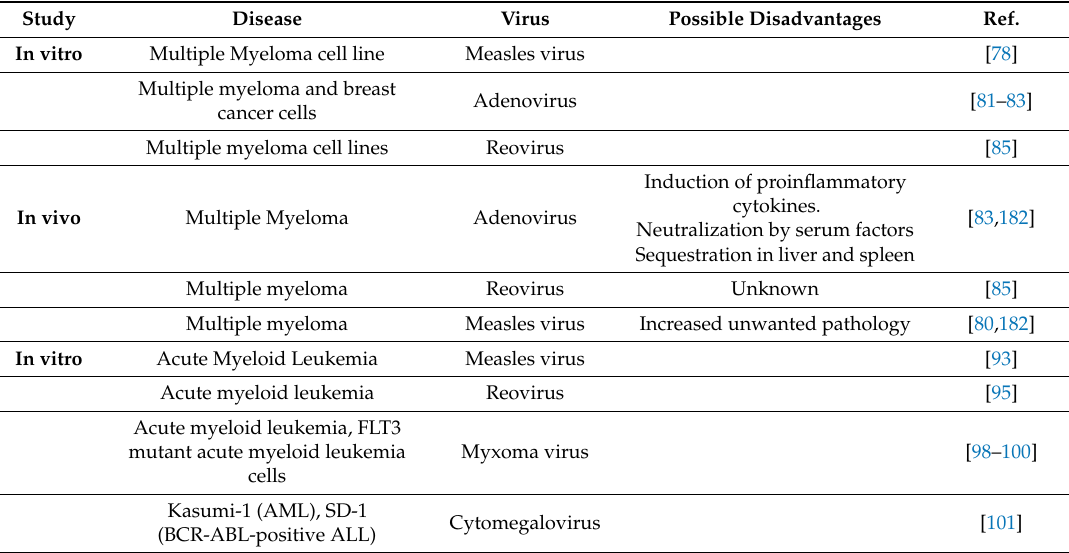
Table 1. Main in vitro and in vivo studies in Hematologic